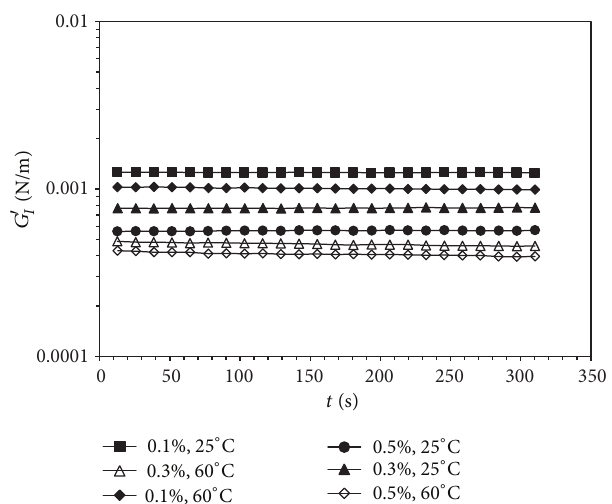
Figure 10: Effect of temperature on 𝐺 󸀠 𝐼 of 0.25% copolymer at different surfactant concentration.